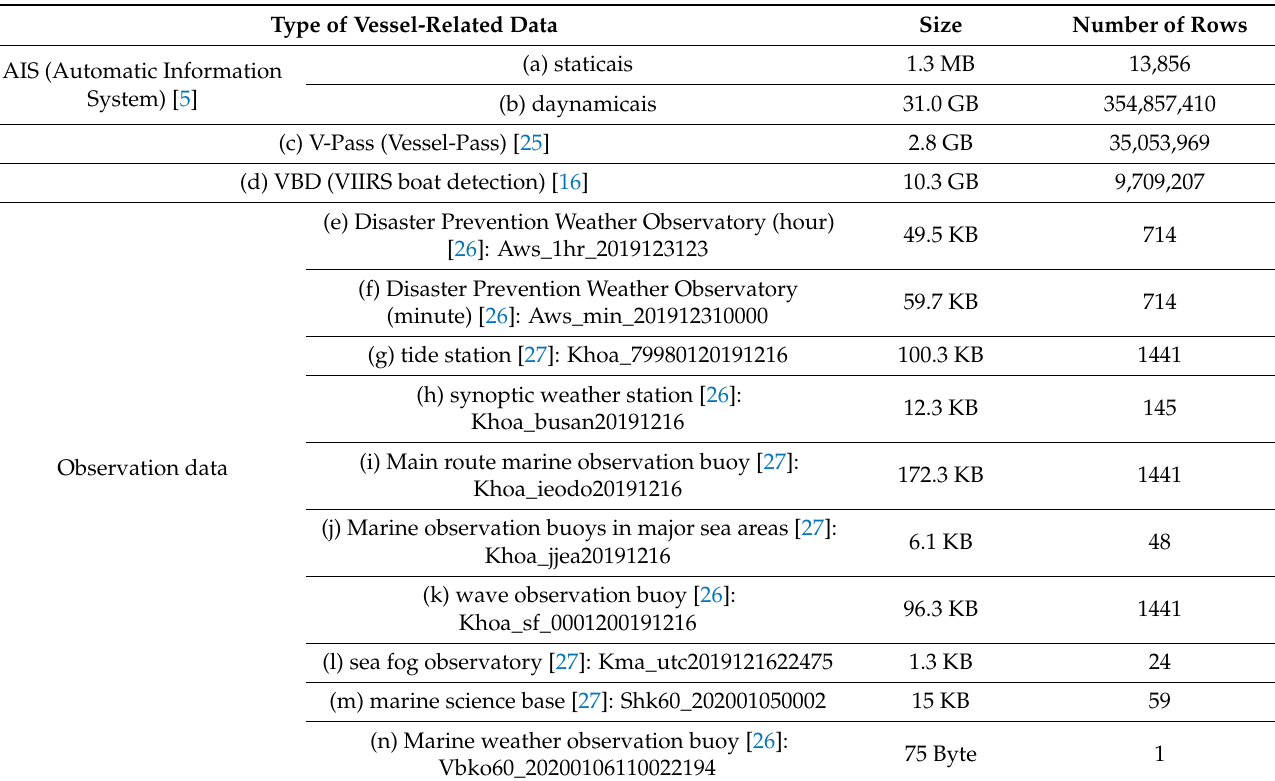
Table 1. Kind of Vessel-related Data import to Marine Data